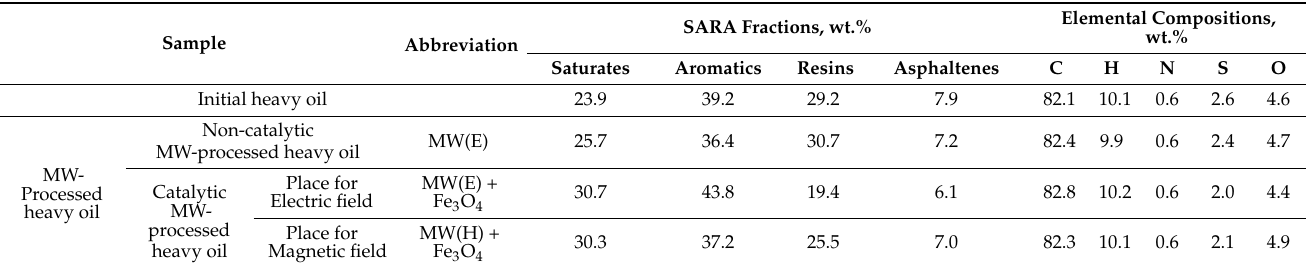
Table 1. SARA and elemental analysis of oil samples in the absence and presence of iron oxide nanoparticles under microwave radiation.